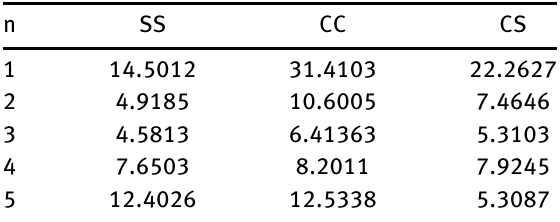
Table 5: Natural frequencies of FG circular cylindrical shell with different boundary conditions (m=1;h/R=0.002;L/R=20; Type D;